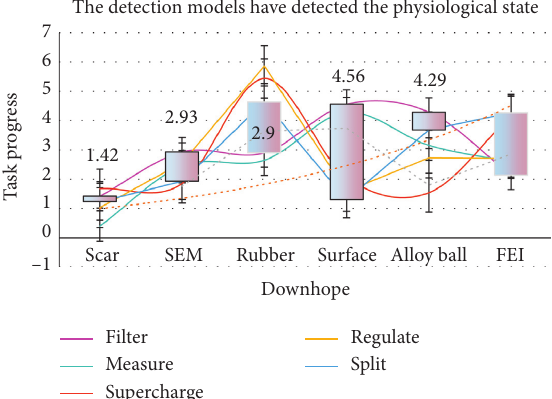
Figure 7: On-site drawing experiment of the emulsion pumping